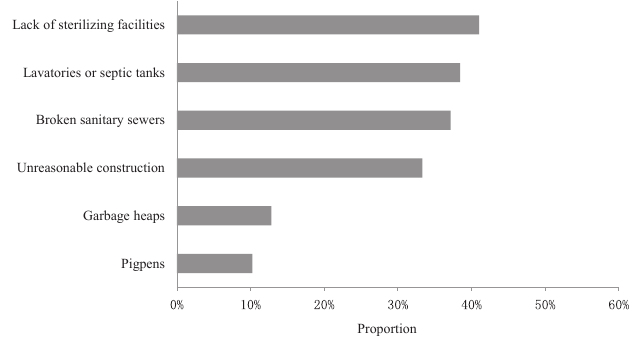
Fig. 2. Proportions of sanitary conditions of wells and its